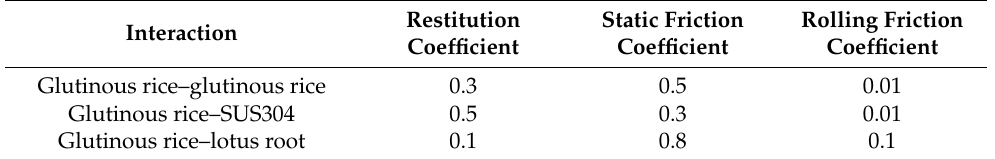
Table 2. Contact parameters between